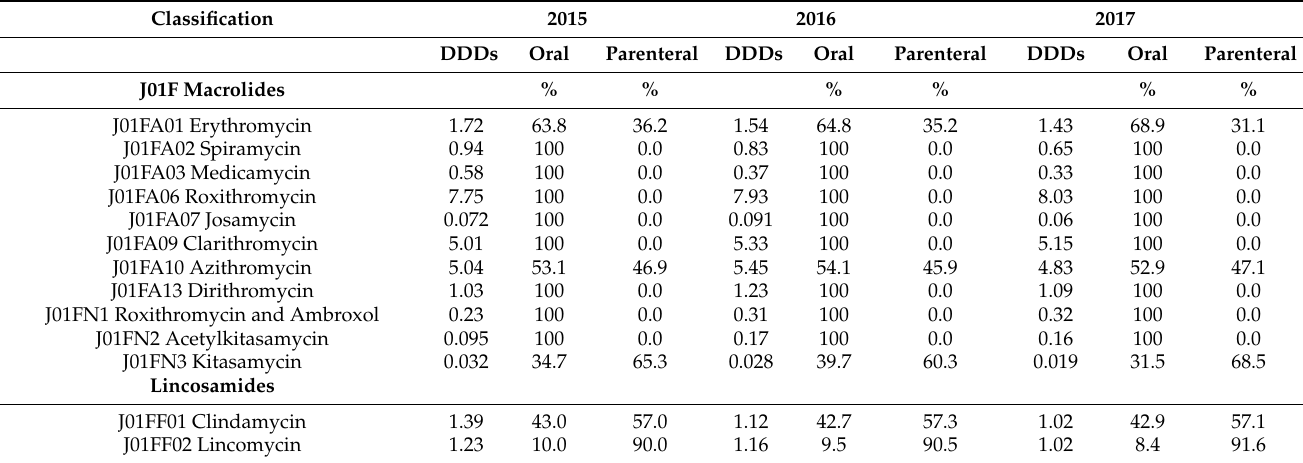
Table 1. Antibiotic consumption by ATC classification in China during 2015–2017.